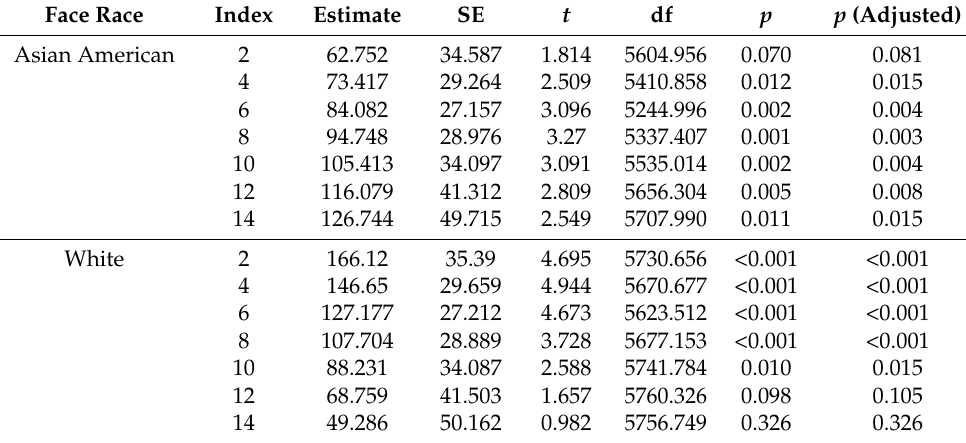
Table 5. The contrasts between fixation duration to the upper and lower halves of faces as a function of face race, following up the 3-way interaction of AOI by face race by index from the diversity model; significant effects indicate that the fixations were longer to the upper region than the lower region at that index value. The Estimate is the estimated difference between the means from the model and the SE is the standard error of those estimates. The p -values were adjusted using the False Discovery Rate